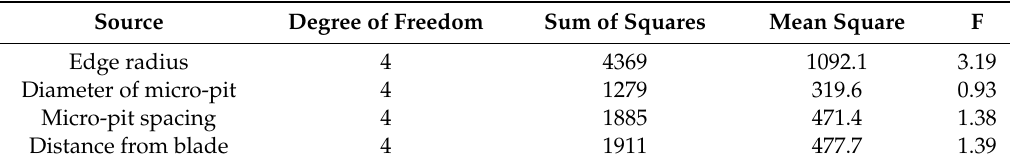
Figure 10. Relationship between the micro-circular pit texture and the blunt edge parameters on the average milling temperature. ( a ) Influence of the micro-pit spacing on the milling temperature. ( b ) Influence of the micro-pit diameter on the milling temperature. ( c ) Influence of the distance from the edge on the milling temperature. ( d ) Influence of the blunt radius of and the cutting edge on the milling temperature. Table 6. Variance analysis of experimental